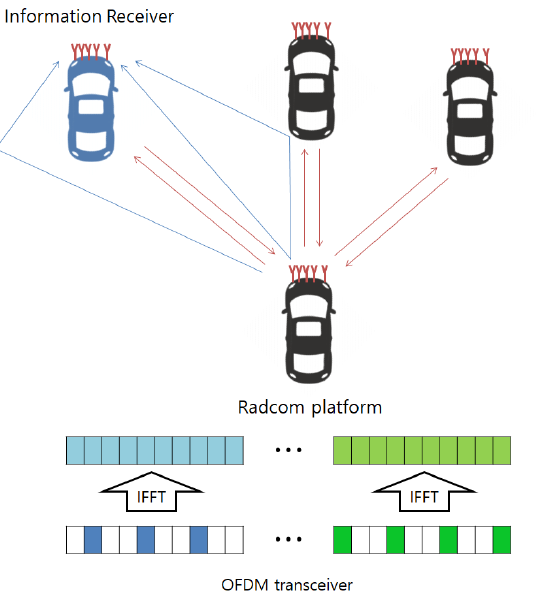
Figure 1. Multiple-input multiple-output (MIMO) orthogonal frequency division multiplexing (OFDM) RadCom system composed of co-located M t Tx antennas and M r radar Rx